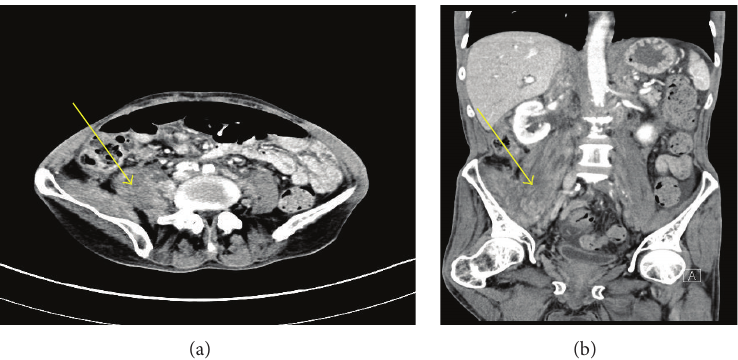
Figure 1: (a) Contrast-enhanced axial CT image through upper pelvis demonstrate enlarged, heterogeneously enhancing right psoas and iliacus muscles with the muscles demonstrating increased and prominent striations (as pointed by arrow). Left psoas is normal. (b) Contrast- enhanced coronal CT image through the abdomen and the pelvis demonstrate enlarged, heterogeneously enhancing right psoas and iliacus muscles (as pointed by arrow) with lateral and anterior displacement of right kidney. No fluid collection is